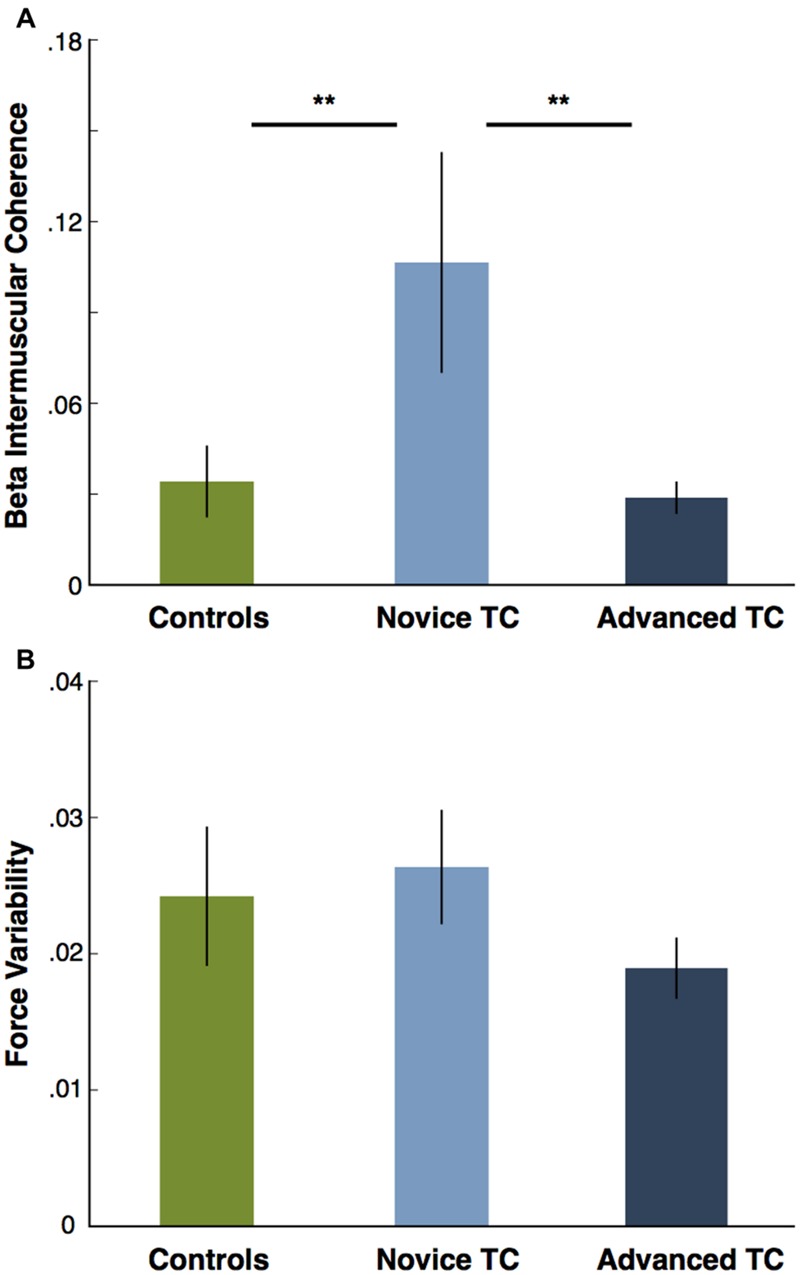
(A) Comparison of beta IMC across three groups (controls, novice practitioners, and advanced practitioners) shows novice TC have significantly higher beta IMC than advanced practitioners (∗∗p < 0.005) and controls (∗∗p < 0.005) while there is no difference between controls and entire TC group or between controls and advanced TC. (B) Comparison of force variability across three groups (controls, novice practitioners, and advanced practitioners) shows no significant differences between groups (p > 0.05), although advanced practitioners manifest a trend toward a significant difference as compared with novice practitioners (p < 0.1). In both plots, error bars display ±1 SEM.